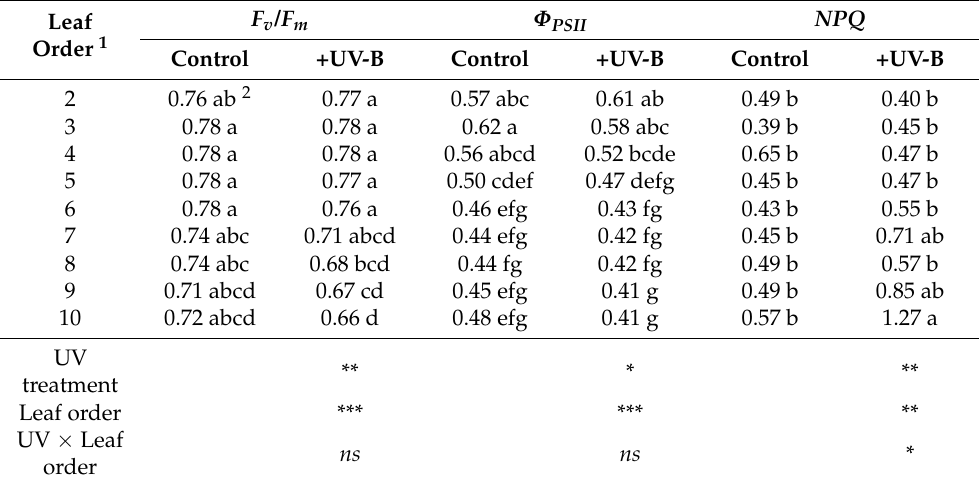
Table 1. Chlorophyll fluorescence parameters of individual leaves of kales under the control and UV-B exposure conditions for 2 days before harvest: F v / F m , the maximum quantum yield of PSII; Φ PSII , the PSII operating efficiency; NPQ , nonphotochemical